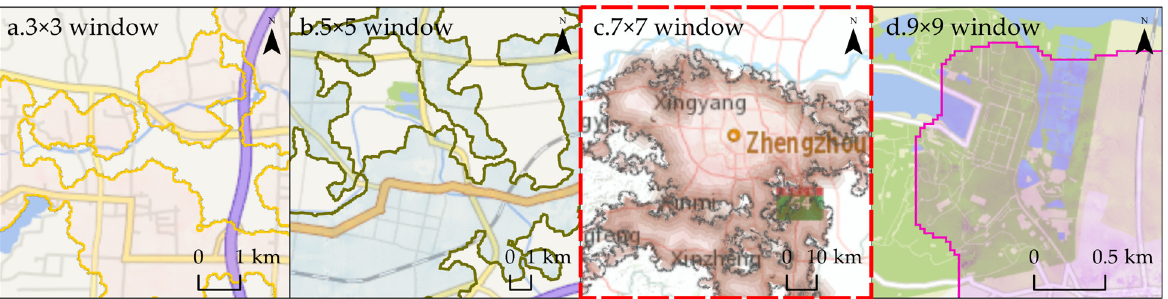
Figure 5. Window size selection analysis.